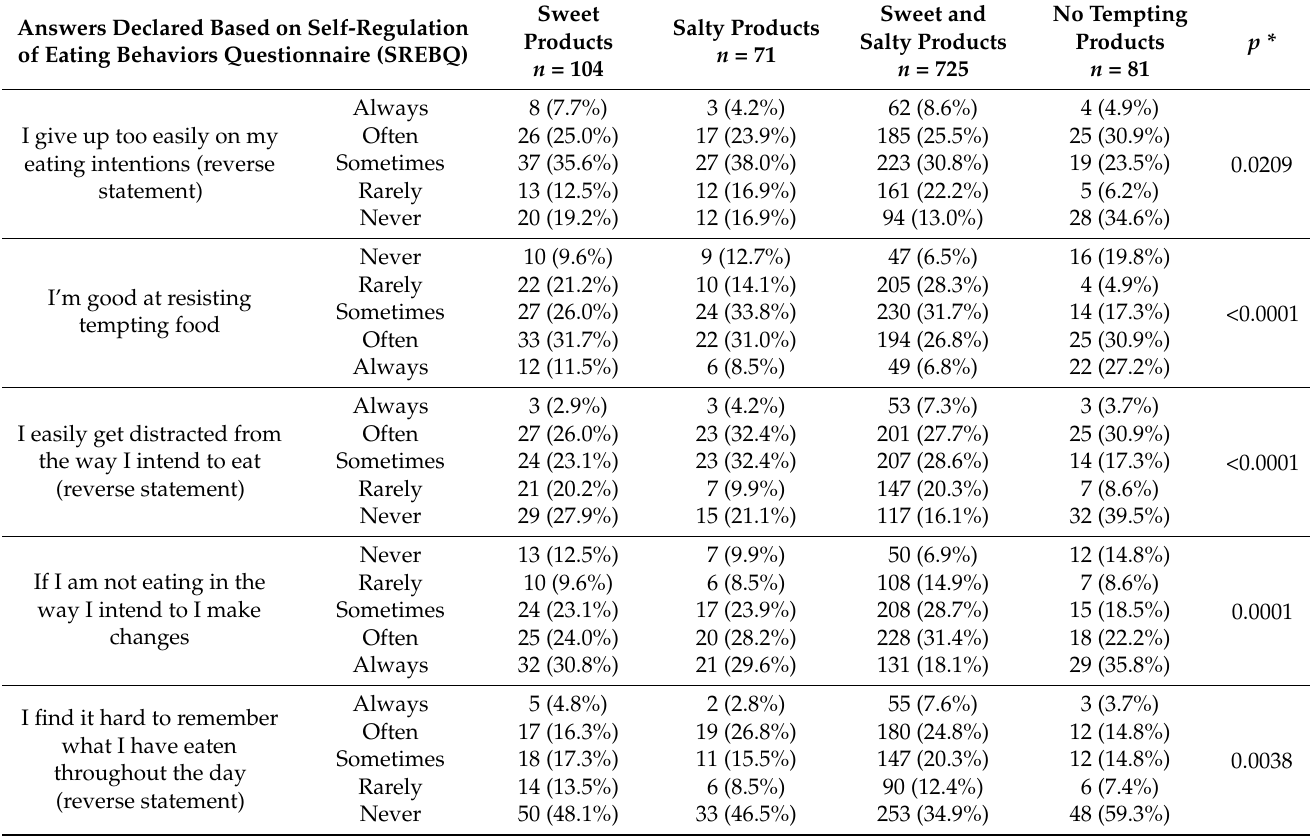
Table 6. The self-regulation of eating behaviors assessed using the Self-Regulation of Eating Behaviour Questionnaire (SREBQ), within the Polish Adolescents’ COVID-19 Experience (PLACE-19) Study ( n = 981) in subsamples stratified by tempting food